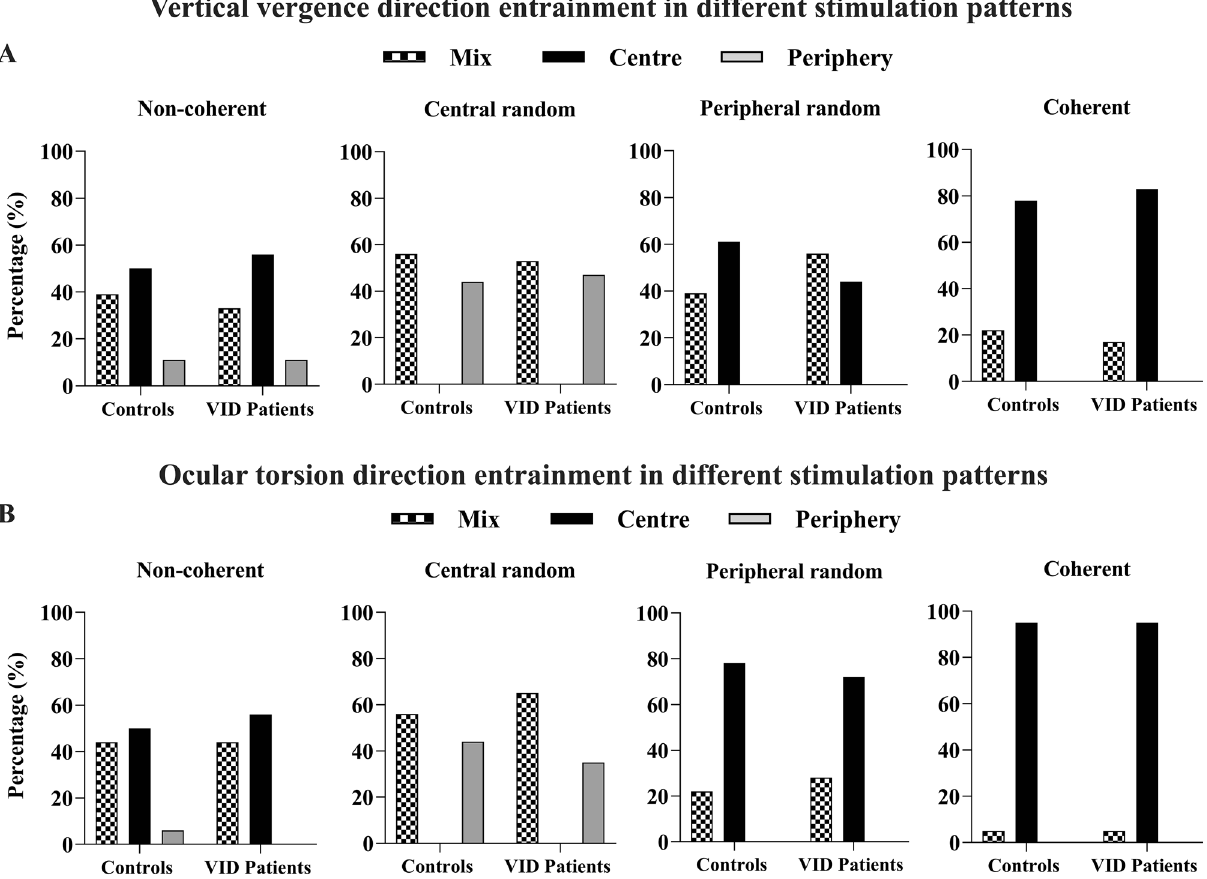
Figure 5. ( A ) Histogram plot illustrating the percentage of vertical vergence direction entrained by the central or peripheral portion of the different optokinetic patterns between groups. ( B ) Histogram plot illustrating the percentage of ocular torsion direction entrained by the central or peripheral portion of the different optokinetic patterns between